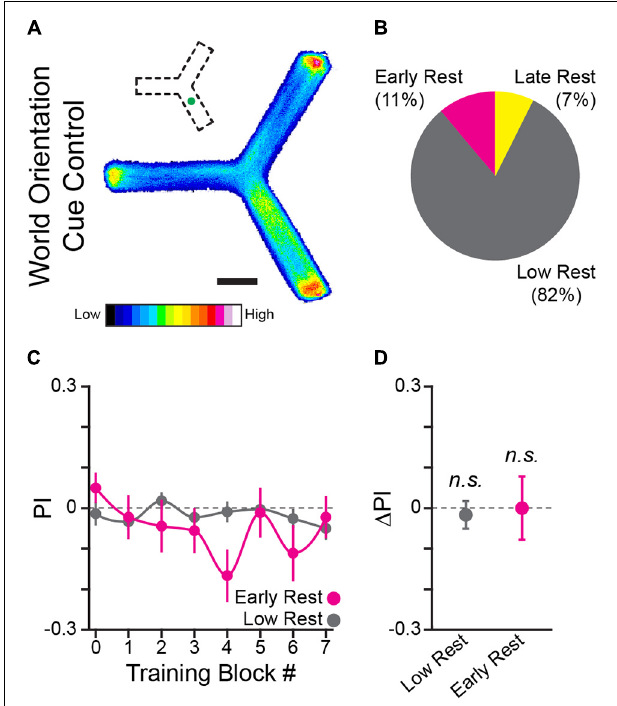
FIGURE 4 | A world orientation cue does not facilitate learning the operant task. (A) Position heatmaps of flies trained with an LED spatial orientation cue. Scale bar is 5 mm. Color shows relative occupancy of each pixel from low to high. Small inset indicates the position of the green light cue. (B) Percentage flies with each rest phenotype. (C) PI by training block for early rest (magenta) and low rest (gray) flies. (D) Mean (cid:49) PI of early rest and low rest flies. Error bars are standard error of the mean, n.s. : groups are not significantly greater than